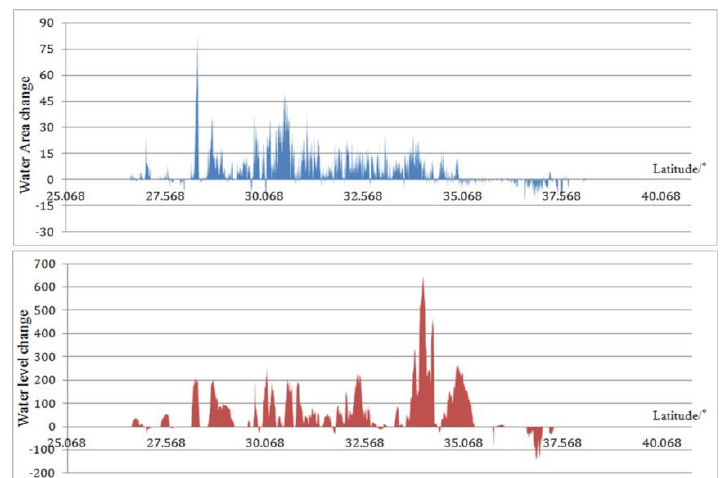
Figure 5. Statistical histogram of lake area and water level change from 2002 to 2012 on TP in latitude lake change is most obvious. The change of the lake area on TP covered by ICESat or ENVISat data in both longitude and latitude direction.